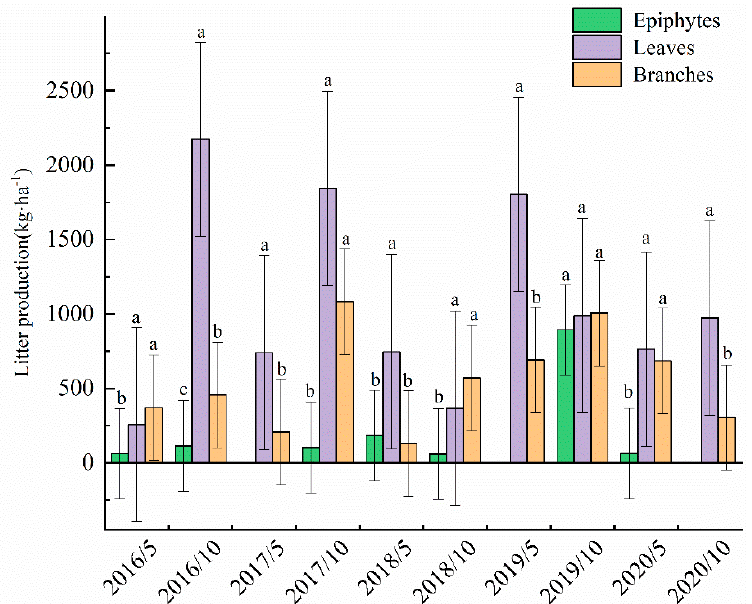
Figure 2. Inputs of three litter components in the A. faxoniana forest from 2016 to 2020. The values represent the means ± SD; n = 45; different lowercase letters indicate that there were significant differences in litter production by different components at the same time ( p < 0.05).